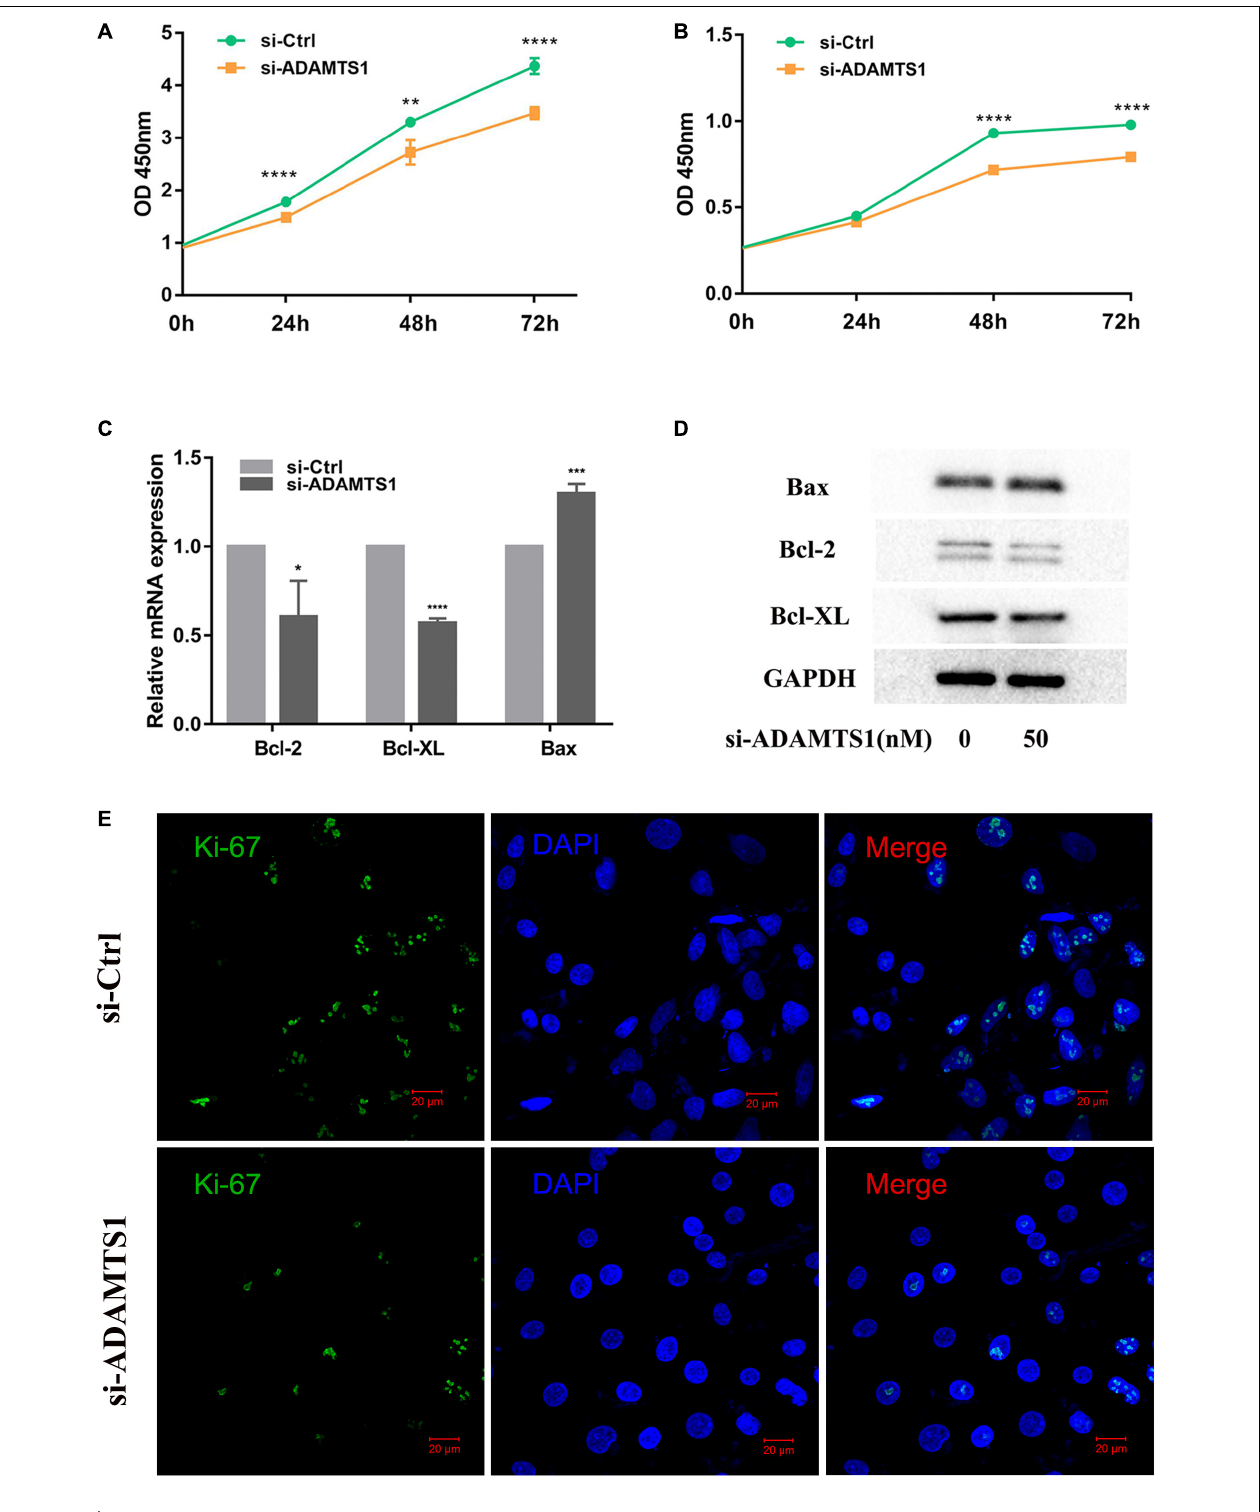
FIGURE 2 | Down-regulation of ADAMTS1 inhibits proliferation in granulosa cell. Cell proliferation was measured by using CCK-8 kit in KGN (A) and primary granulosa cells (B) at 0, 24, 48, and 72 h. Primary granulosa cells were transfected with siRNA at the concentration of 50 nM for 48 h, and the mRNA (C) and protein levels (D) of Bcl-2, Bcl-XL, and Bax were analyzed. The Ki-67 staining was performed after transfection of si-ADAMTS1 to evaluate the cell proliferation (E) . GAPDH gene was used as an internal control. * Indicates p < 0.05, ** indicates p < 0.01, *** indicates p < 0.001, and **** indicates p < 0.0001.